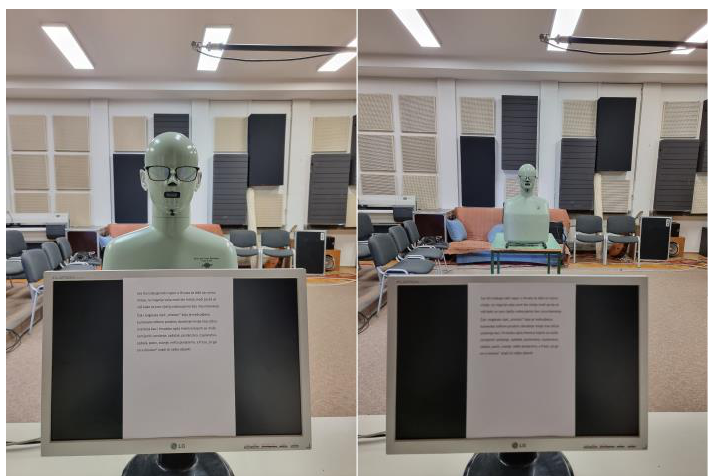
Figure 1. Two positions of the visual stimulus in the experiment; left: within the personal space of the subject (at 85 cm); right: within the social space of the subject (at 280 cm).